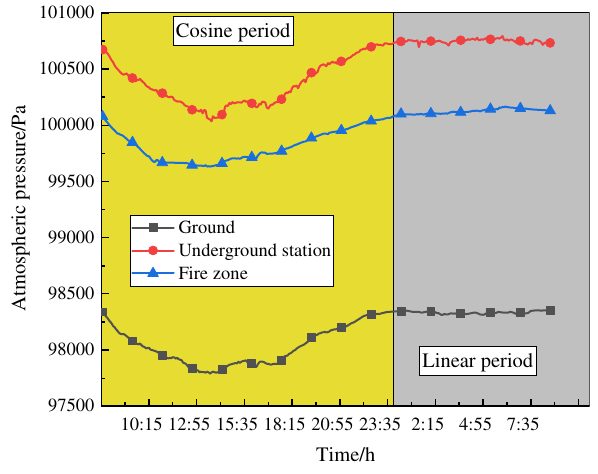
Fig. 1 Continuous monitoring of gas pressure at three different monitoring points in a mine